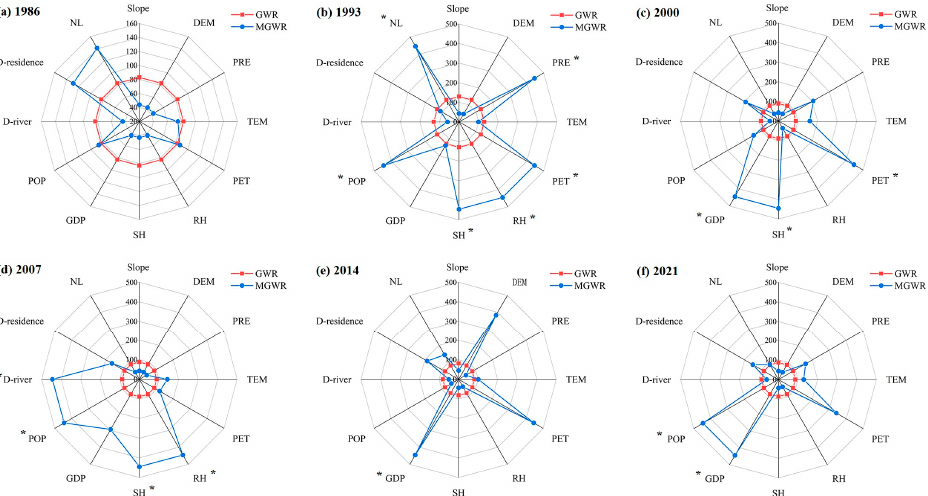
Figure 8. Bandwidth of GWR and MGWR from 1986 to 2021. (a–f): 1986; 1993; 2000; 2007; 2014; 2021. Note: * represents global scale.